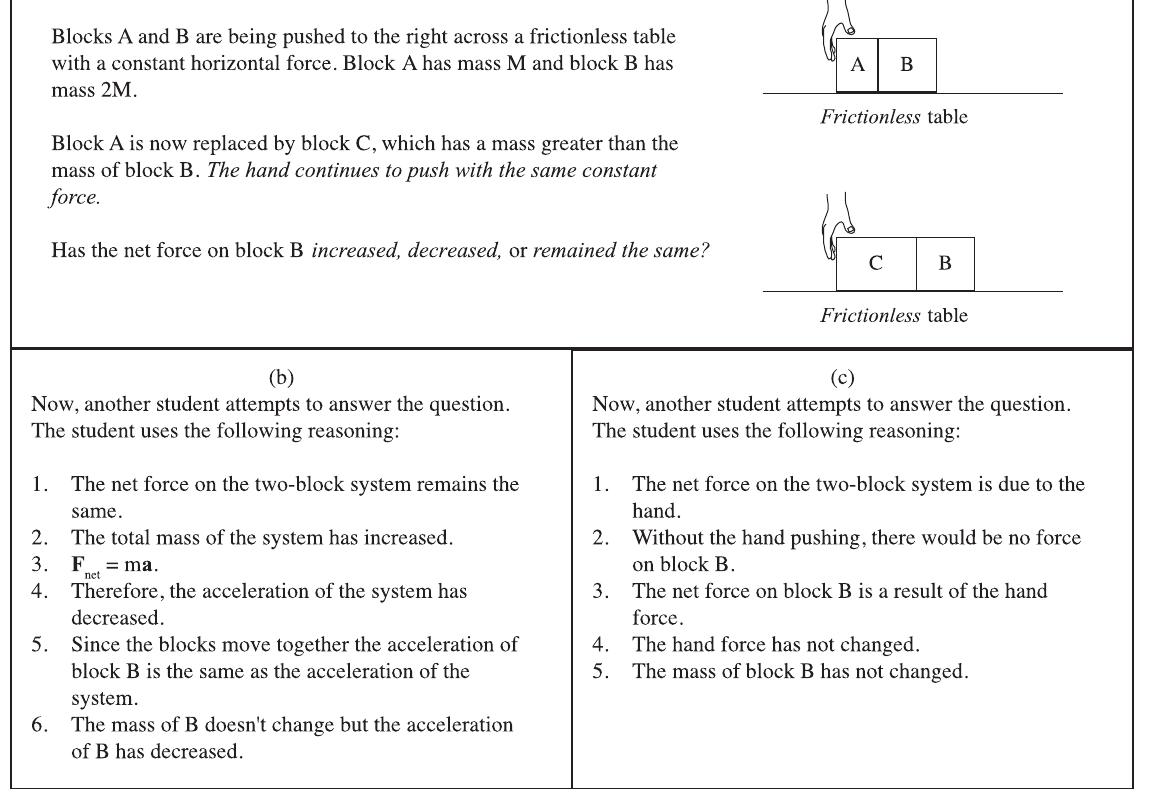
FIG. 2. Follow task 2, the Newton ’ s laws follow task. The base task is shown in (a). The reasoning chain shown in (b) supports the correct conclusion that the net force on block B has decreased. The reasoning chain shown in (c) is incorrect and suggests that the net force on B has not